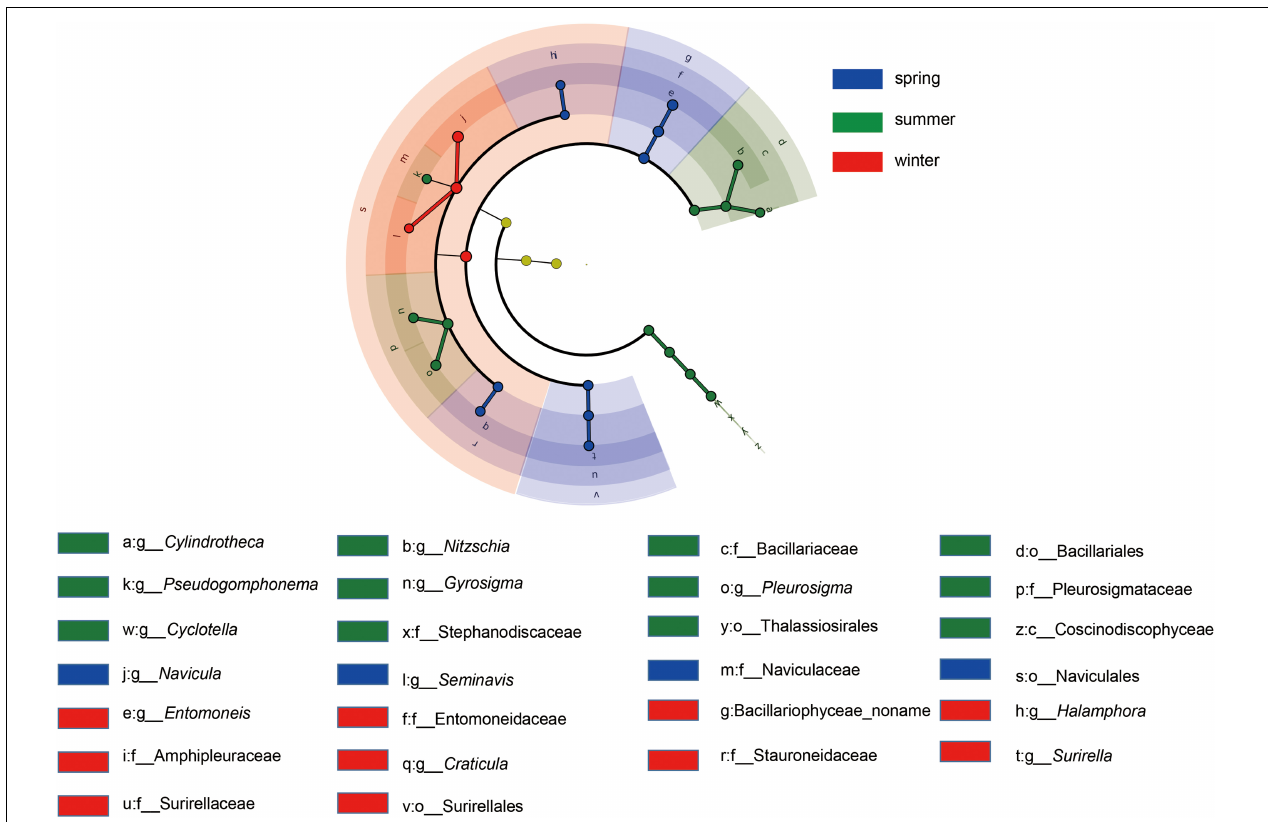
FIGURE 5 | LEfSe cladogram of benthic diatom community for different seasons. Benthic diatom taxa in all samples, assigned to the kingdom (innermost), phylum, class, order, family, and genera (outermost), are used to determine taxa most likely to explain differences for different seasons. Differentially abundant taxa are colored according to the slope regions in which they are most abundant; i.e., blue, green and red circles stand for biomarkers in spring, summer, and winter.